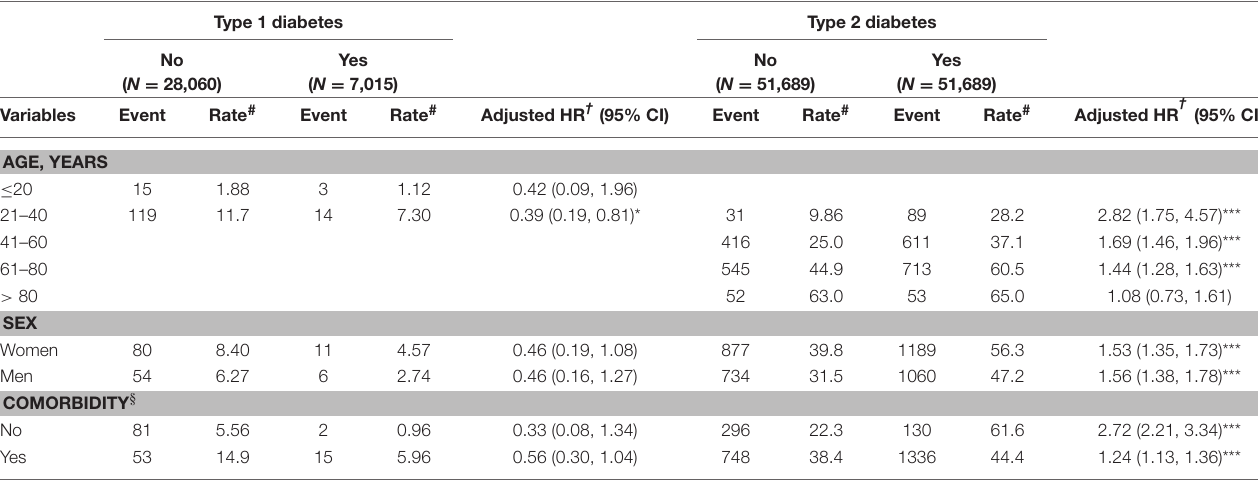
TABLE 3 | Incidence and hazard ratios of gallbladder stone disease measured by age, sex, and comorbidity in type 1 diabetes or type 2 diabetes cohort compared with the corresponding control